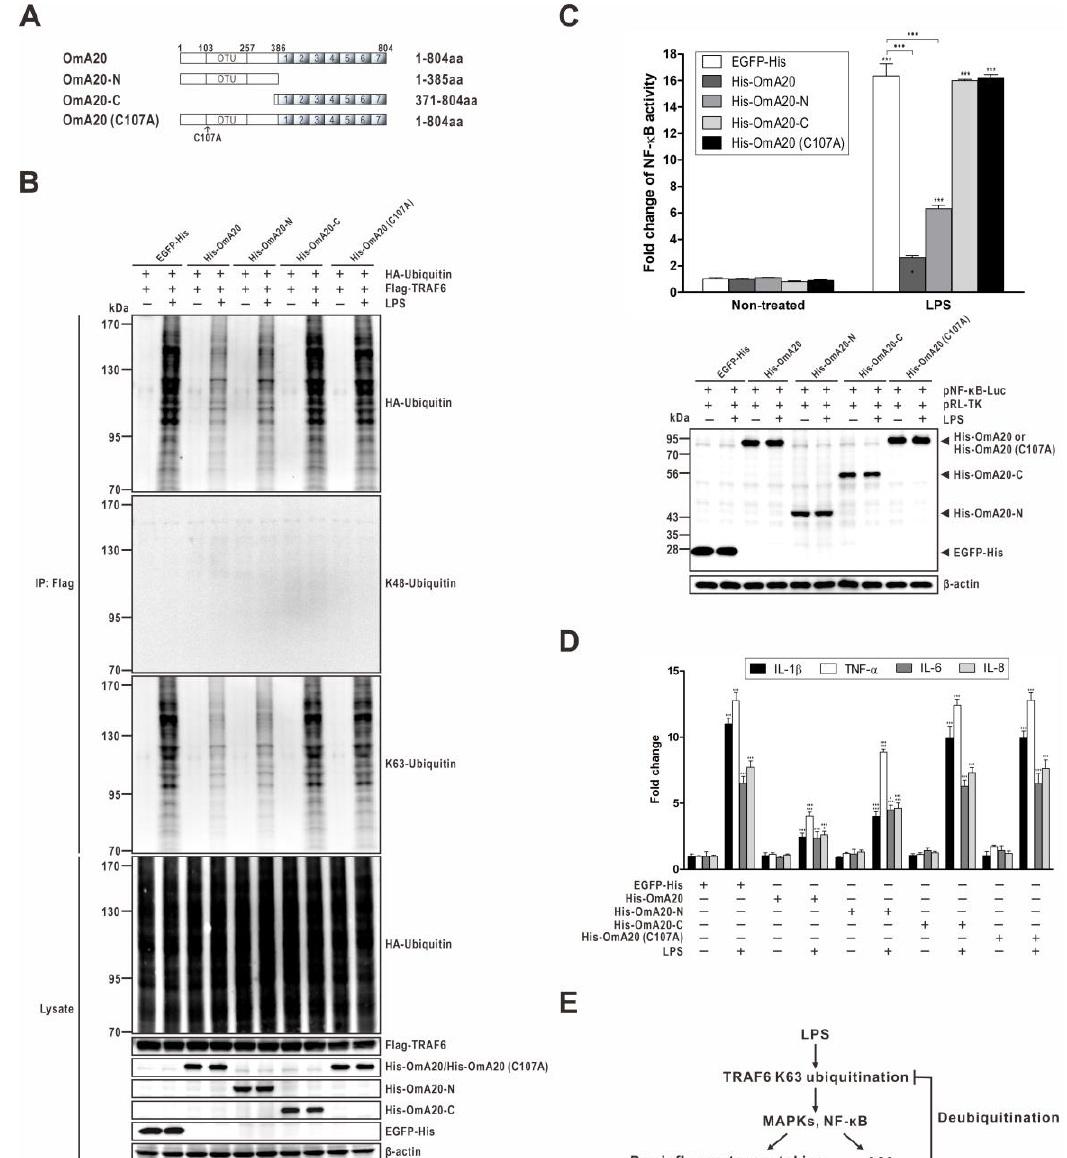
Figure 7. Effect of OmA20 mutants on the ubiquitination of TRAF6 and activation of NF- κ B in RTH-149 cells stimulated with LPS. ( A ) A schematic diagram of OmA20 and its mutants used in this study. ( B ) RTH-149 cells were transfected with expression vectors for various combinations (above lanes) of His-OmA20, His-OmA20-N, His-OmA20-C, His-OmA20 (C107A), EGFP-His, Flag-TRAF6, and HA- Ubiquitin. After transfection, cells were stimulated with LPS (10 μg /mL) for 12 h. Flag-TRAF6 was isolated by IP followed by IB (with anti-HA, anti-K48-linkage specific polyubiquitin, and anti-K63- linkage specific polyubiquitin antibodies) to examine its ubiquitin conjugation. Cell lysates were subjected to IB to detect